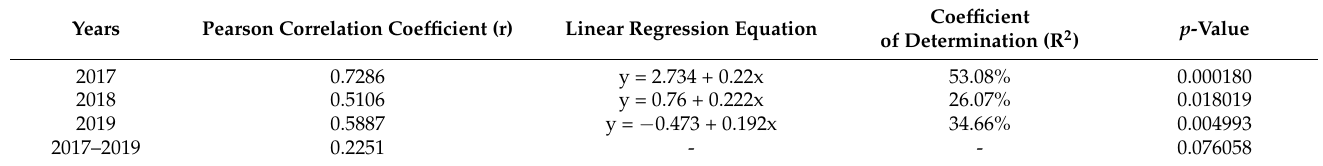
Table 12. Linear relationships between grain yield and potassium content in maize leaf blades at BBCH 65.